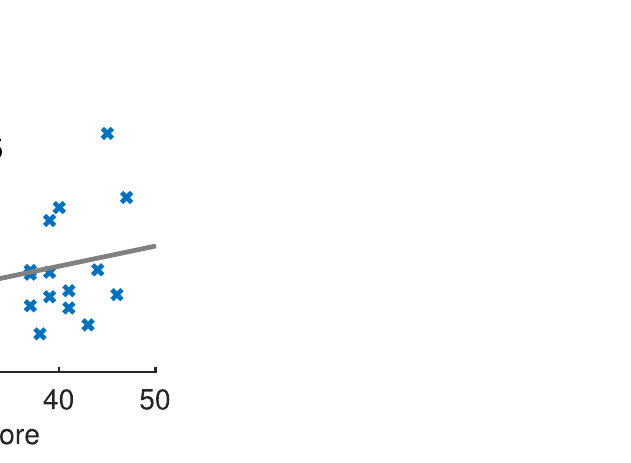
Figure 3. Reward sensitivity and RSES score (r = 0.35, p =